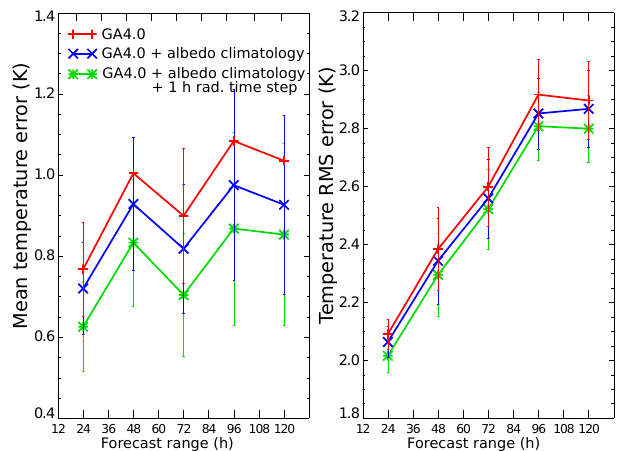
Figure 7. Mean bias (left) and RMS error (right) in screen-level temperature vs. observations over North American land from a set of 12 N320-resolution forecast case studies from summer 2011 and 2012 run from operational ECMWF